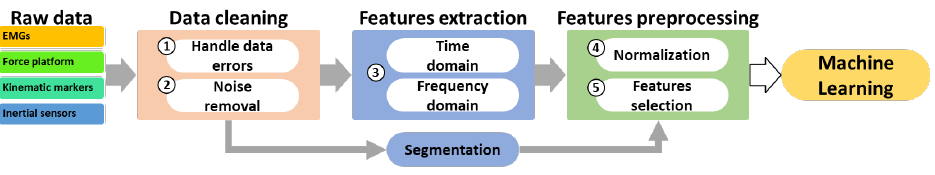
Figure 10. Data analysis